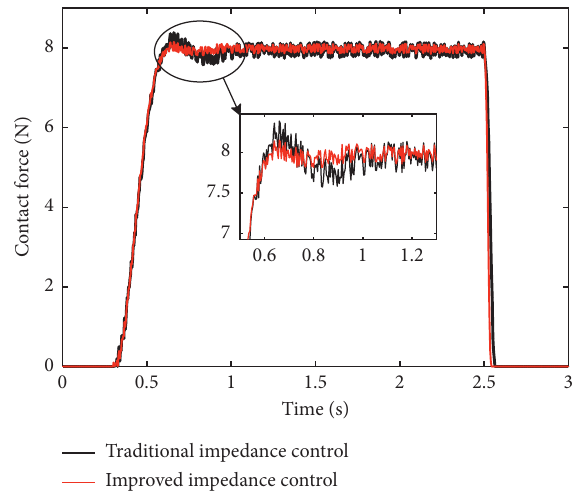
Figure 17: Actual contact force varying with time.